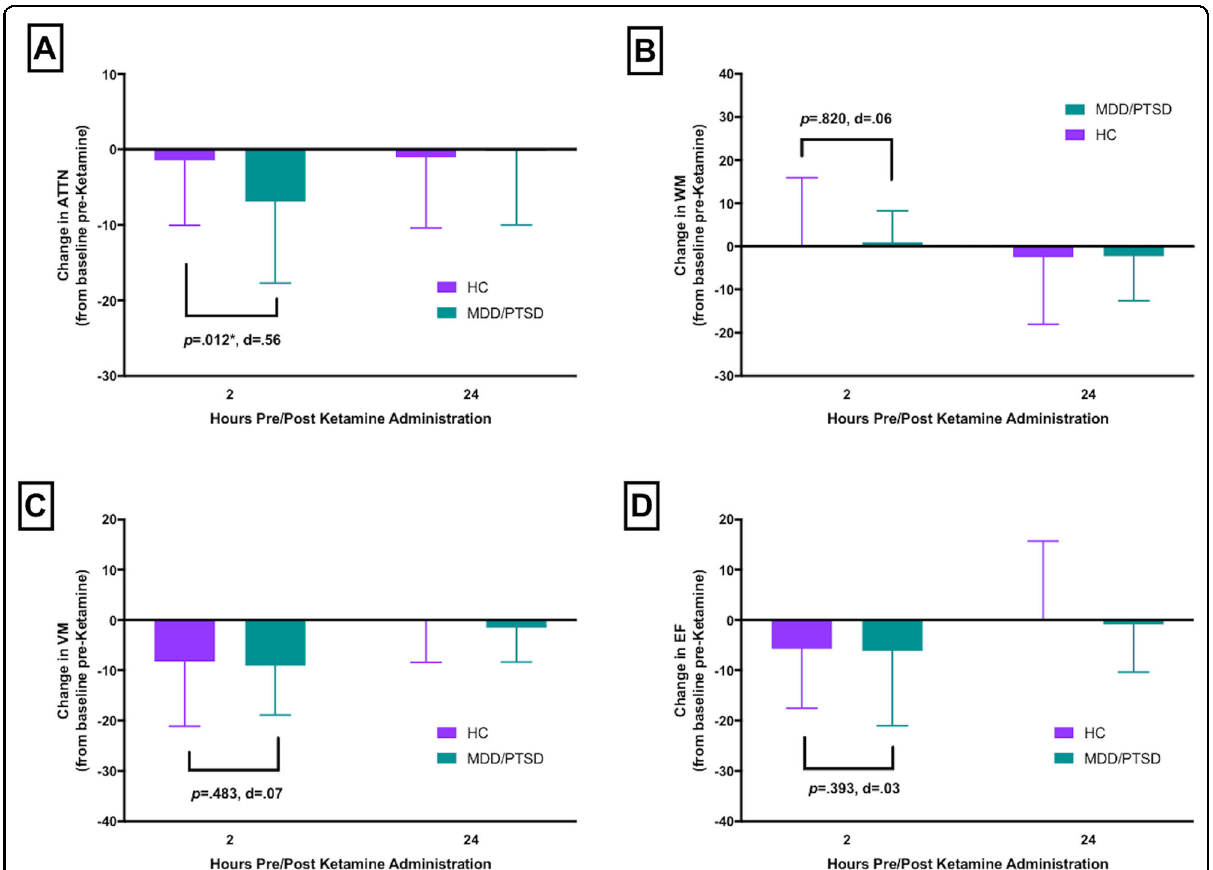
Fig. 3 Mean and SD for change scores at each timepoint relative to baseline for each Cogstate score/composite score. HC healthy control, MDD major depressive disorder, PTSD posttraumatic stress disorder, ATTN attention composite score, WM working memory composite score, EF executive functioning, VM verbal memory. * p <